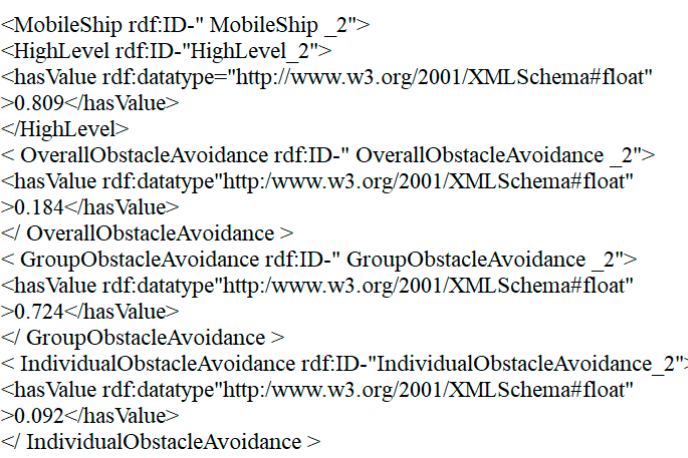
Figure 13. OWL format file.